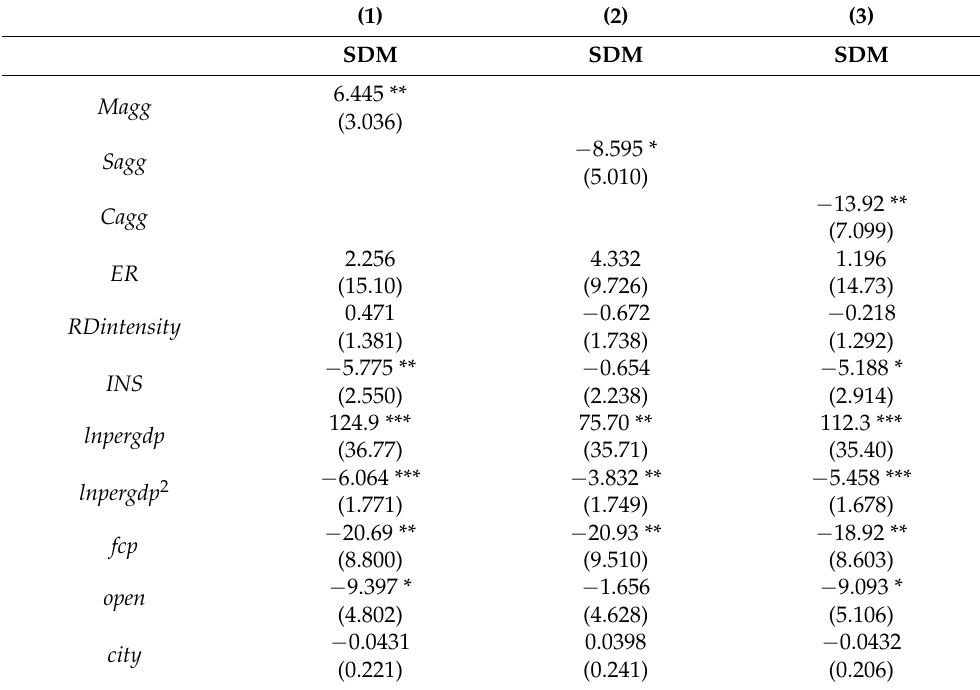
Table 10. Spatial econometric regression results in the effect of industrial agglomeration on air